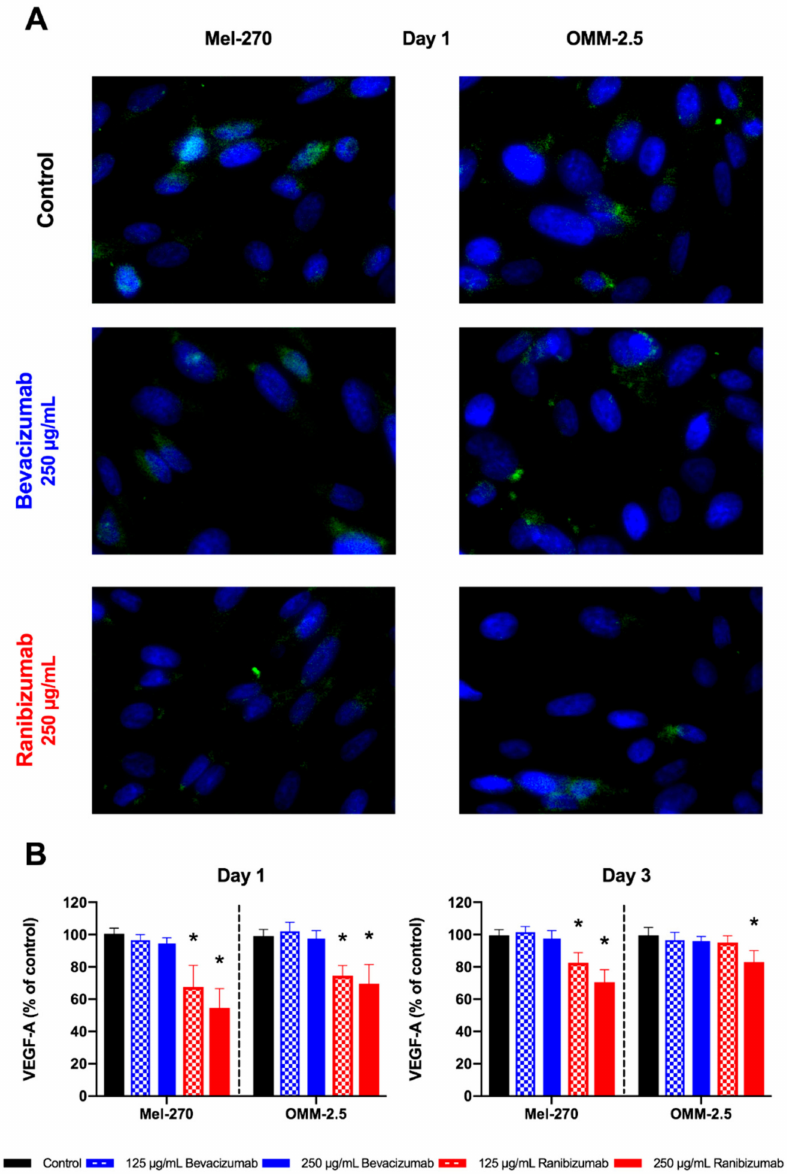
Figure 3. Intracellular VEGF-A levels after a one-day exposure to bevacizumab or ranibizumab. ( A ) Intracellular VEGF-A was evaluated by measuring the number of Alexa488-positive (green) particles. Cell nuclei were stained with DAPI (blue). Images were acquired at 400 × magnification. ( B ) Bevacizumab did not reduce the intracellular VEGF-A levels in any cell type, dosage, or time-interval. Ranibizumab led to a statistically significant decrease of intracellular VEGF-A in both cells at day one. This significant e ff ect persisted for both concentrations of ranibizumab in Mel-270 cultures at day three, but only for the 250 µ g / mL dose in OMM-2.5 cells. * p < 0.05. 2.3. More Ranibizumab than Bevacizumab Was Taken up into Uveal Melanoma